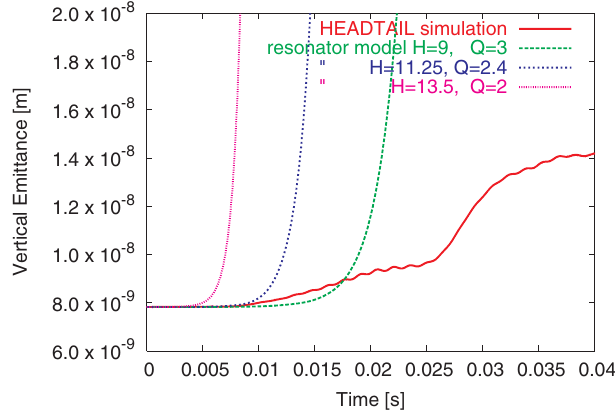
FIG. 17. (Color) Vertical emittance vs time in LHC at injection (cid:2) 6 (cid:6) 10 11 m (cid:4) 3 from a HEADTAIL PIC simulation (red for (cid:2) e line) and from a HEADTAIL simulation with broadband-resonator model. For the latter, different combinations of H plotted, with a constant product Q (cid:6) H